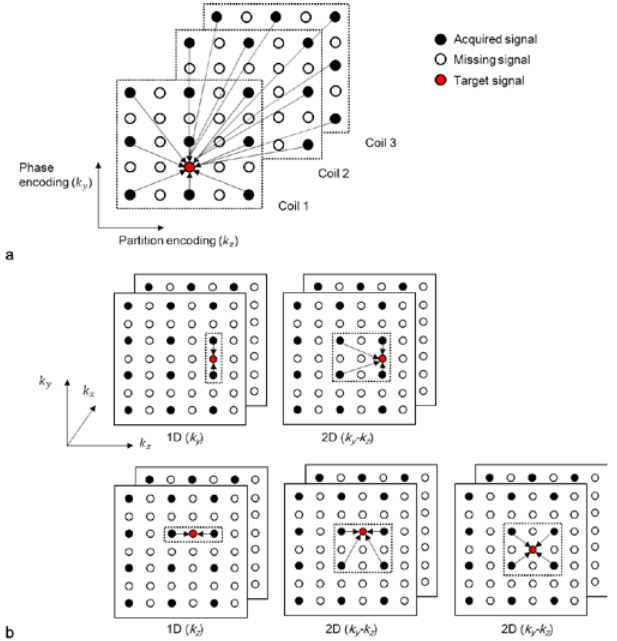
Figure 2. ( a ) A schematic diagram of the 2D-GRAPPA algorithm and ( b ) different types of kernels. Each circle represents a data point in the k-space of each coil. A missing data point in k-space can be estimated by a linear combination of acquired signals.